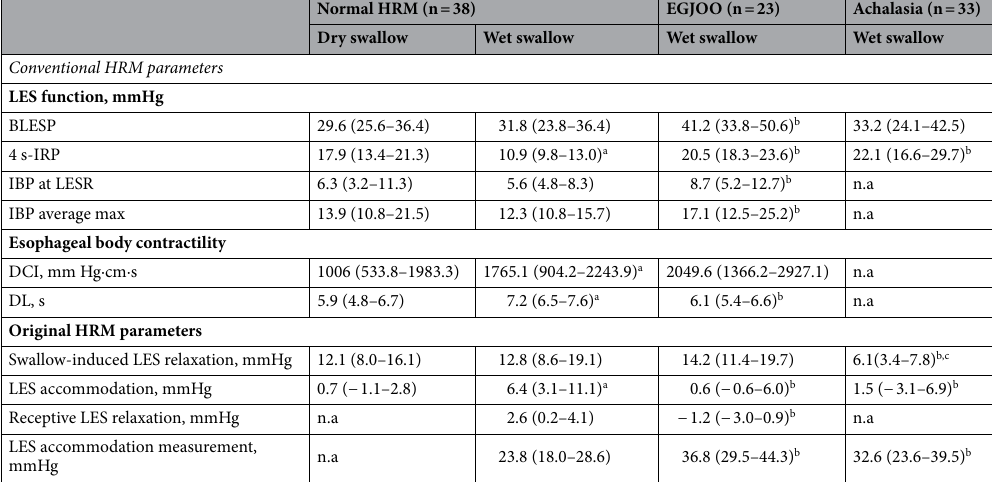
Table 2. HRM pressure topography parameters of dry and wet swallows in the patients with normal HRM and of wet swallow in the patients with EGJOO and patients with achalasia. EGJOO esophagogastric junction outflow obstruction; HRM high-resolution manometry; LES lower esophageal sphincter; IRP integrated relaxation pressure; IBP intrabolus pressure; LESR lower esophageal sphincter relaxation; DCI distal contractile integral; DL distal latency. Results are shown as the median (interquartile range). a p < 0.05 vs. Dry swallow in normal HRM. b p < 0.05 vs. Wet swallow in normal HRM. c p < 0.05 vs. EGJOO.